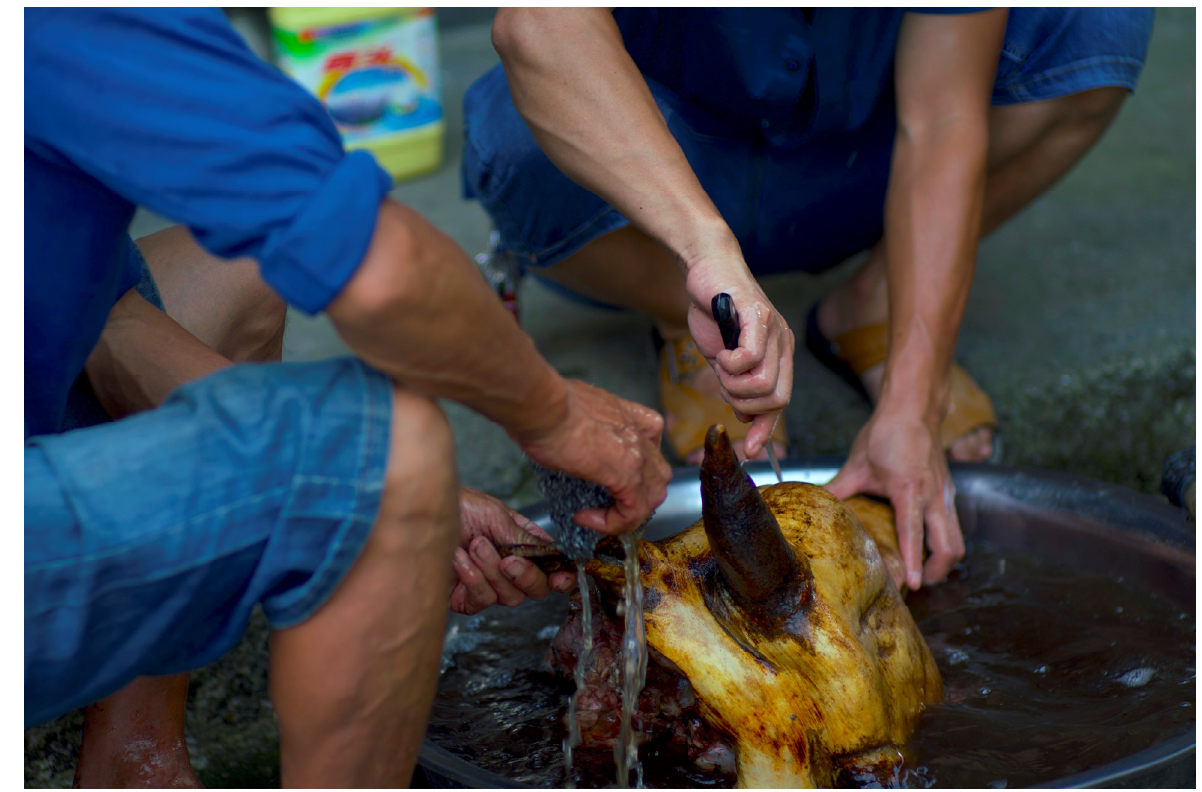
Figure 7. The flaying of the ox head by members of the host family to make the meat an offering to the gods. (Photo: Thomas Riccio).